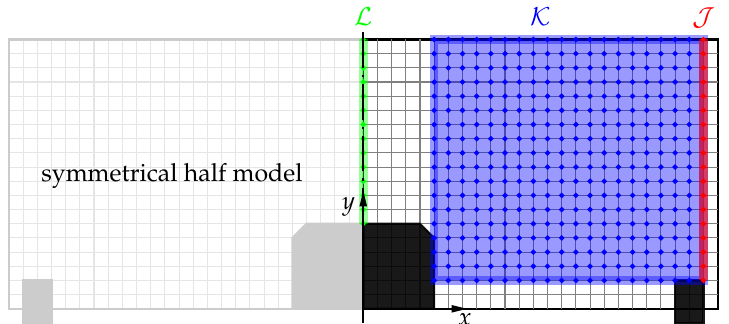
Figure 3. FE shell model with three predefined node sets, an exact size of 20mm ×